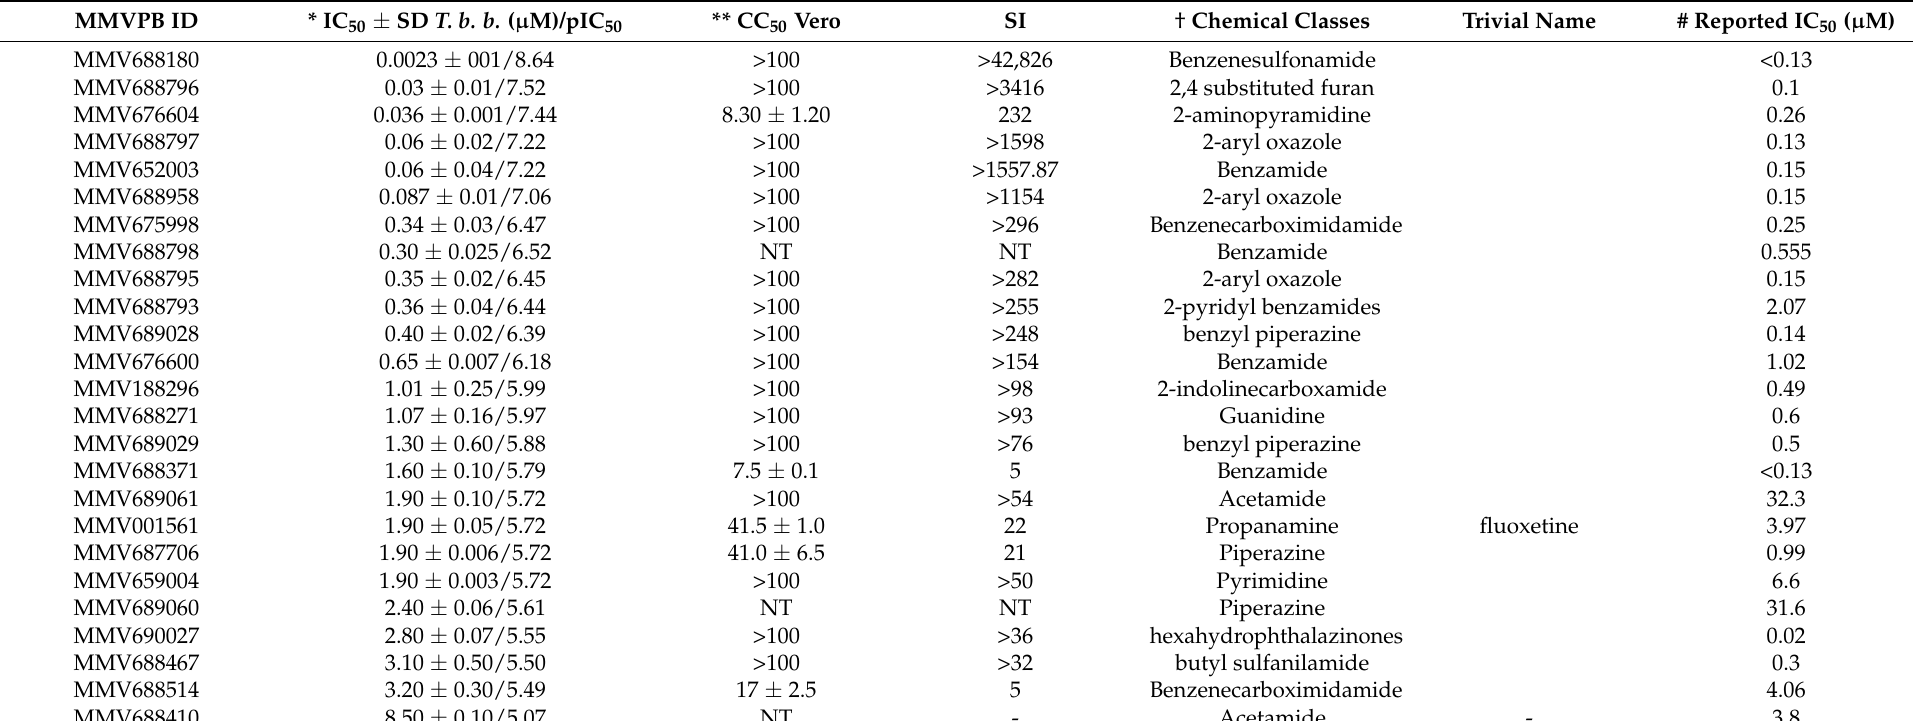
Table 2. In vitro antitrypanosomal and cytotoxic activities of the 25 MMVPB compounds with known anti-kinetoplastid